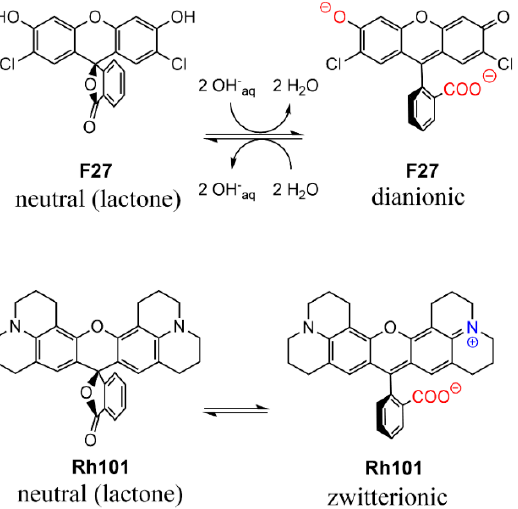
Figure 4. Prevalent charge states of the dyes in water at pH 7.4. Positively charged moieties are highlighted in blue and the negatively charged moieties are highlighted in red.